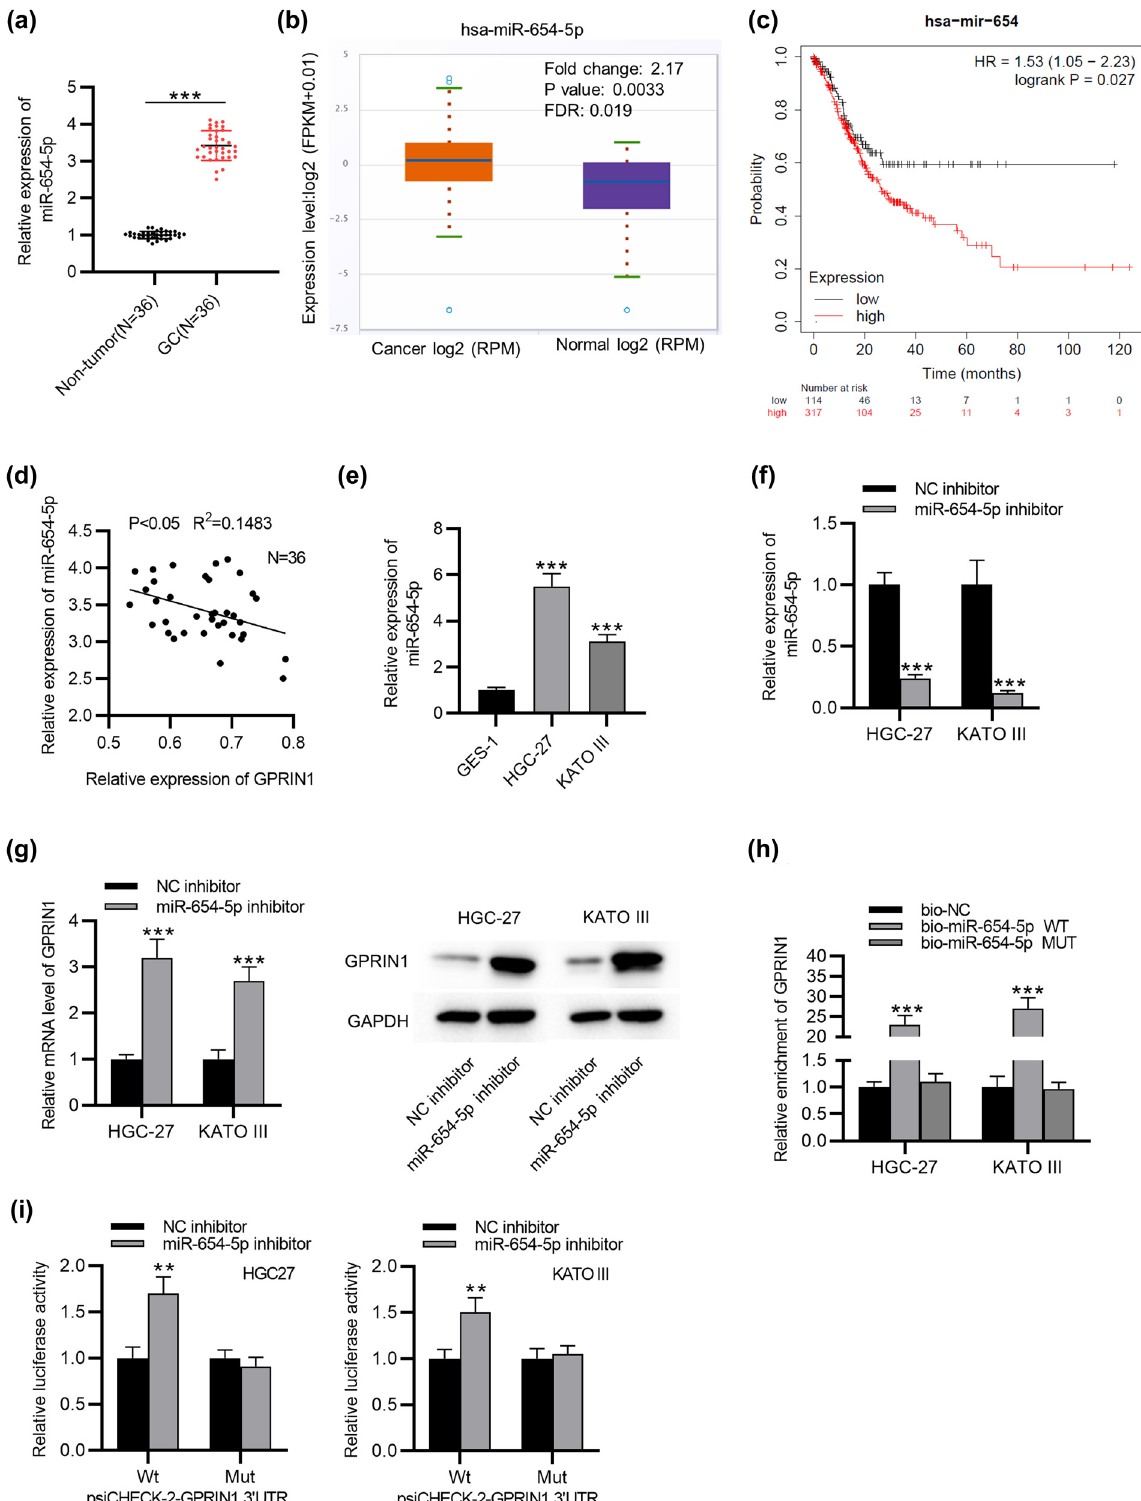
Figure 3: miR - 654 - 5ptargetsGPRIN1inGCcells. ( a ) RelativemiR - 654 - 5plevelin36GCtissuescomparedtothatin36normaltissueswasassessedby RT - qPCR. ( b ) miR - 654 - 5p expression pattern in 372 GC samples and 32 normal samples was analyzed according to starBase website ( http://starbase. sysu.edu.cn/ ) . ( c ) High level of miR - 654 - 5p was related to poor overall survival of GC patients according to Kaplan - Meier Plotter website. ( d ) The correlationbetween miR - 654 - 5p and GPRIN1 expression levels in GC tissues was analyzedbySpearman ’ s correlation analysis. ( e ) Relative miR - 654 - 5p level in GC cells compared to that in GES - 1 cells was measured by RT - qPCR. ( f ) HGC - 27 and KATO III cells were transfected with miR - 654 - 5p inhibitor, and RT - qPCR assessed the transfection e ffi ciency. ( g ) RT - qPCR and Western blotting were conducted to reveal relative mRNA and protein levels of GPRIN1 in GC cells transfected with miR - 654 - 5p inhibitor compared to GC cells transfected with NC inhibitor. ( h ) An RNA pulldown assay showed the relativeenrichmentofGPRIN1inbio - miR - 654 - 5pWTandbio - miR - 654 - 5pMUTcomparedtothatinbio - NC. ( i ) Aluciferasereporterassaywasconducted to reveal the binding of miR - 654 - 5p and GPRIN1 3 ′ UTR. ** p < 0.01, *** p <